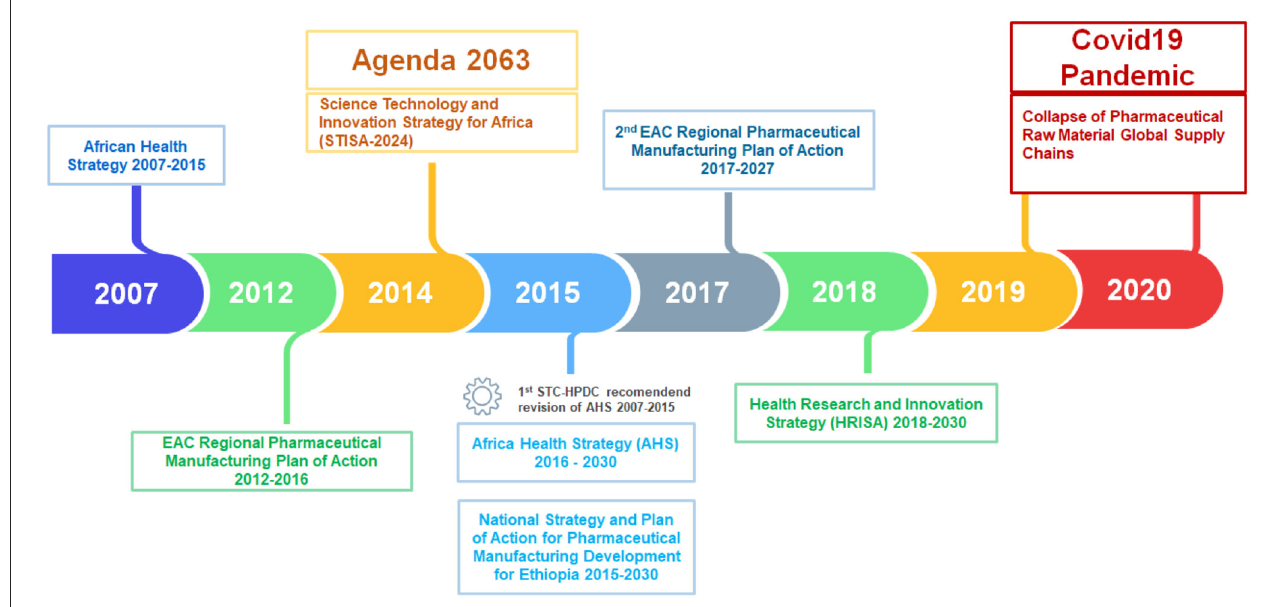
FIGURE1 Pharmaceutical policies, initiatives, and related programs developed at the supranational level. Source: Compiled by author from various publications and